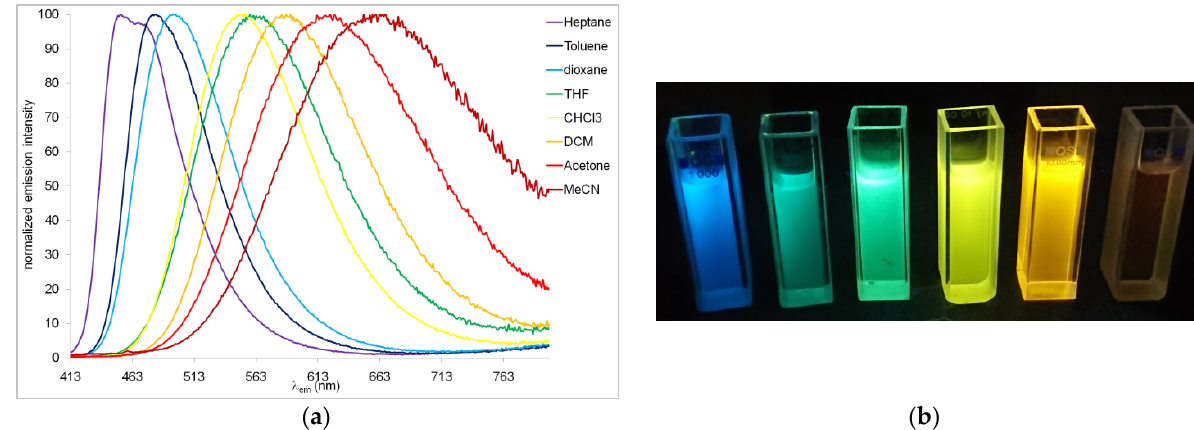
Figure 2. ( a ) Normalized emission spectra of compound 1 in a series of aprotic solvents ( λ exc = 403 nm); ( b ) Fluorescence color changes experienced by 1 in various solvents (from left to right: n-heptane, toluene, 1,4-dioxane, chloroform, DCM and MeCN). The picture was taken in the dark upon irradiation with a handheld UV lamp ( λ em = 366 nm).